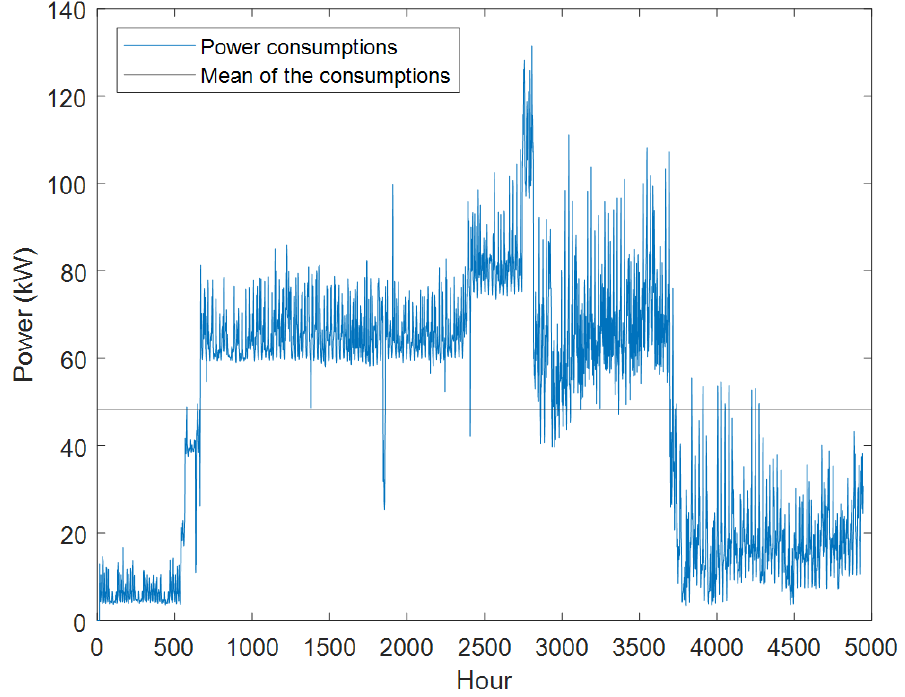
Figure 3. Power consumption (kW) per time (hours) at the sports centre in Musakola, Arrasate.